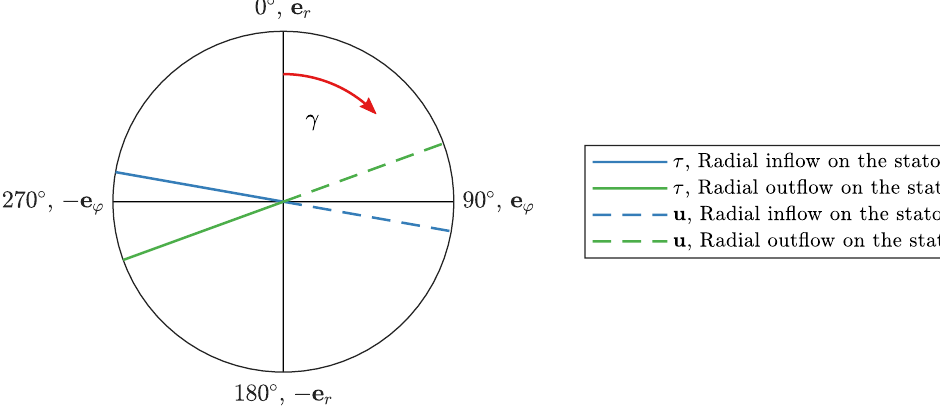
Figure 10. Definition of the wall shear stress angle γ